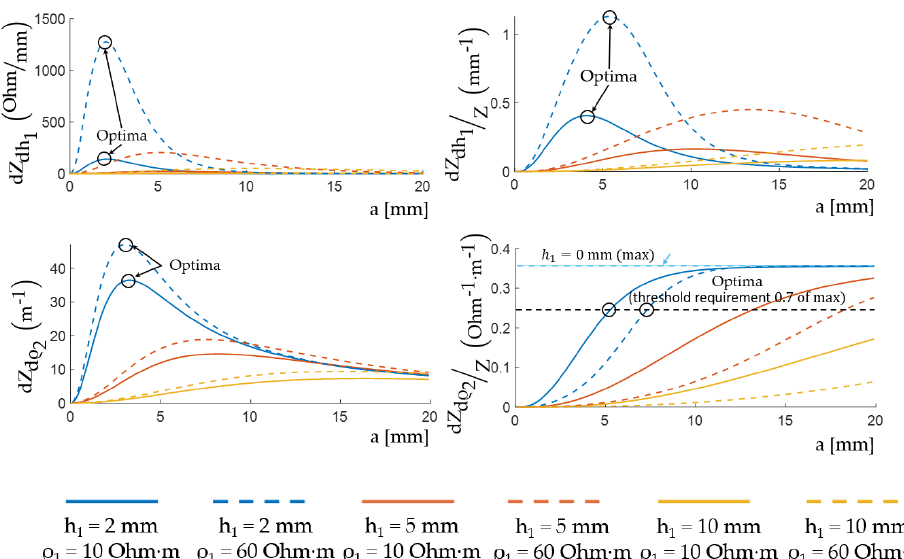
Figure 10. Relationship between the two-layer model EI expression partial derivatives and the interelectrode distance.